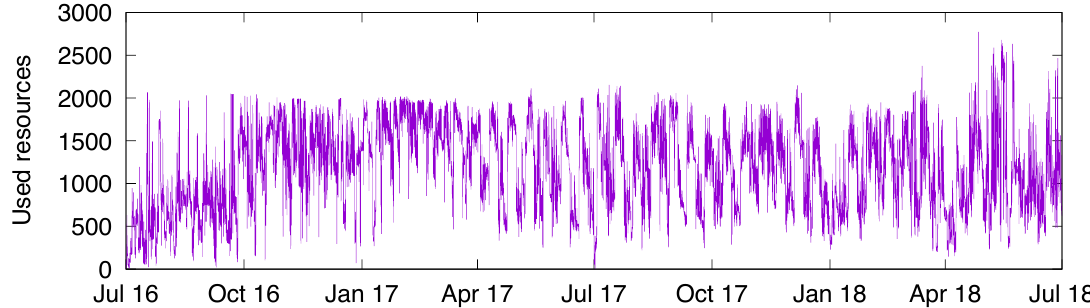
Figure 8. Workload (number of used resources) of NEF over